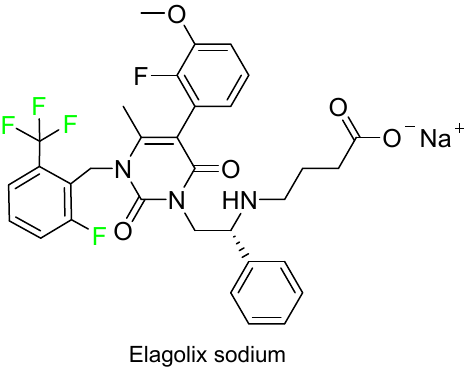
Figure 12. Structure of apalutamide.